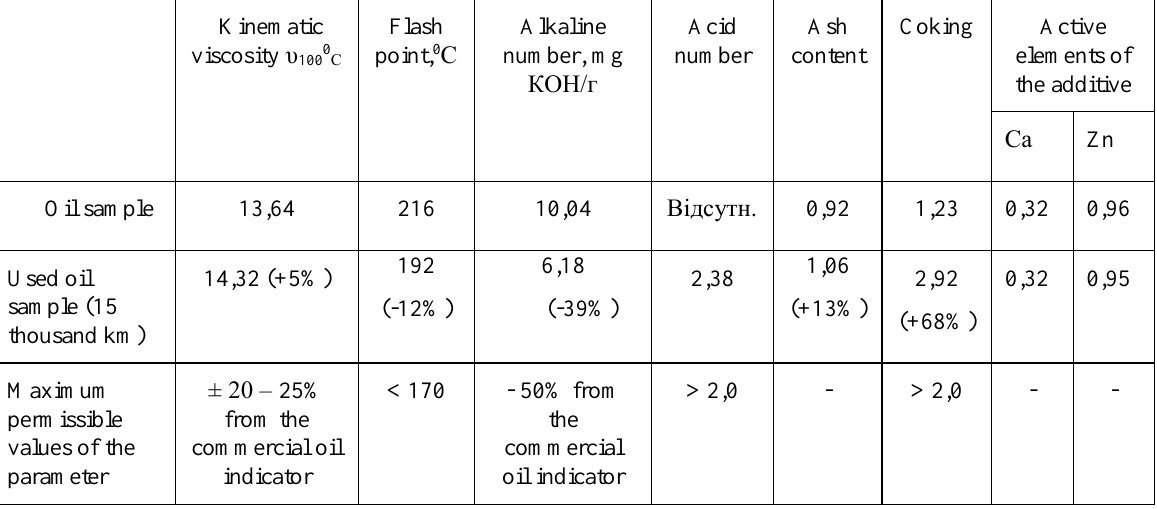
Basic physical and chemical characteristics of Mobil-1 0w-40 engine